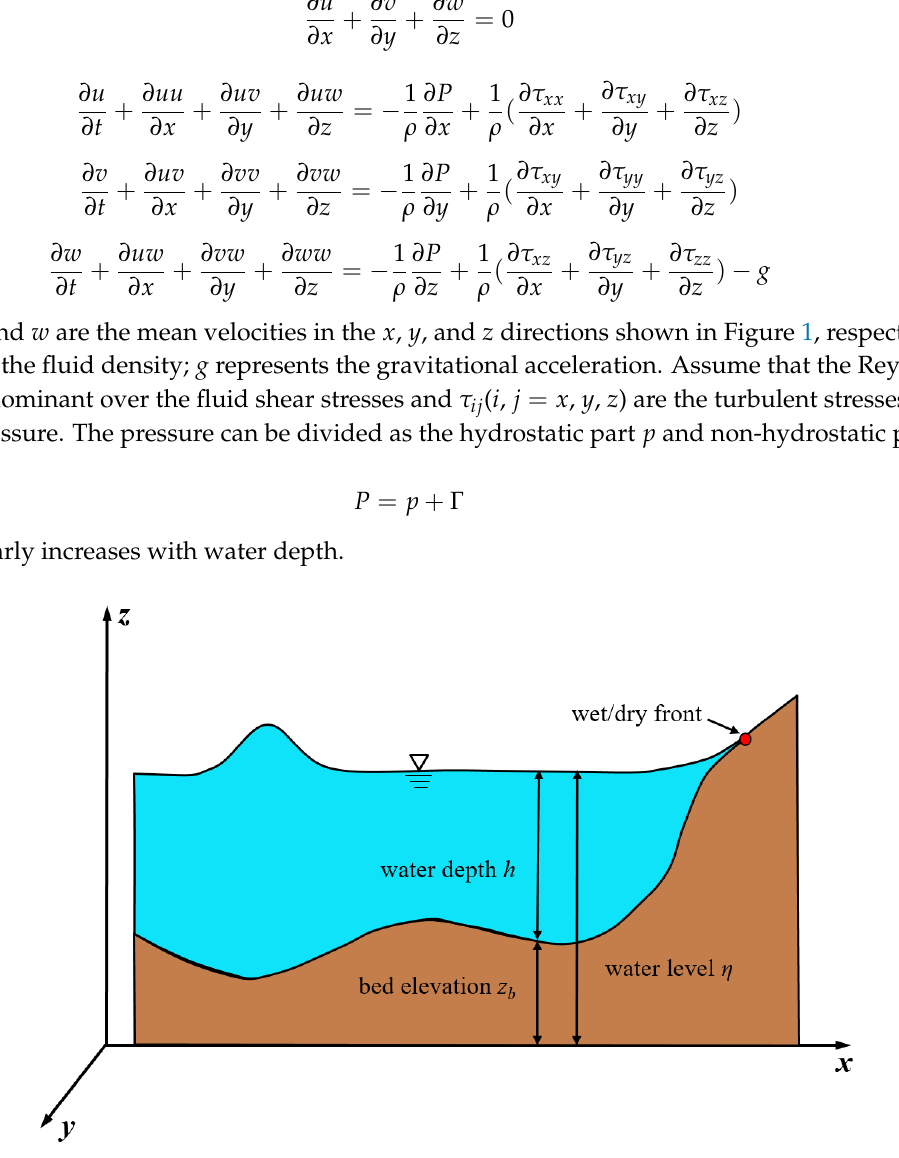
Figure 1. Sketch of the computational